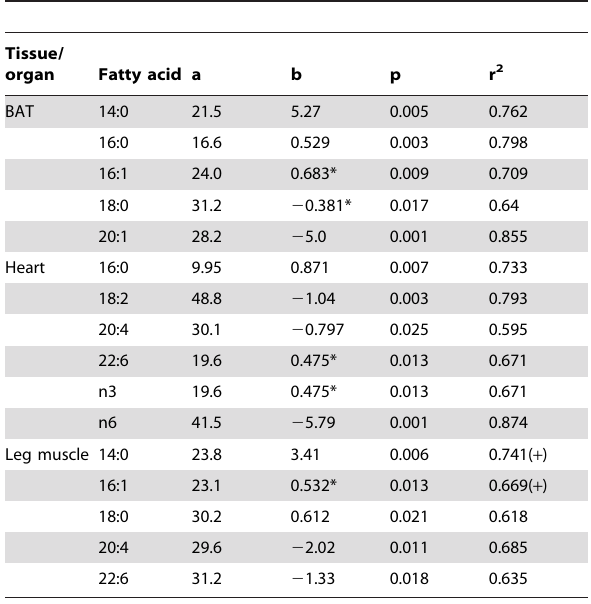
Table 6. Linear regression analyses of mean surface temperature (T s ) as a function of fatty acid concentration.